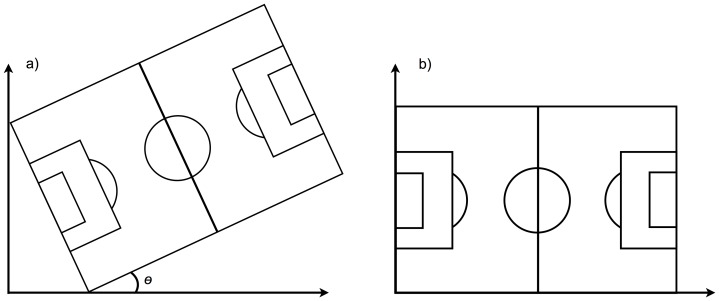
A rotation matrix was applied rotating the data through an angle θ.A rotation matrix was calculated from the field vertices and applied to the players' positions, rotating the data through an angle θ in order that the longitudinal displacements were aligned with the x-axis and the lateral displacements were aligned with the y-axis.